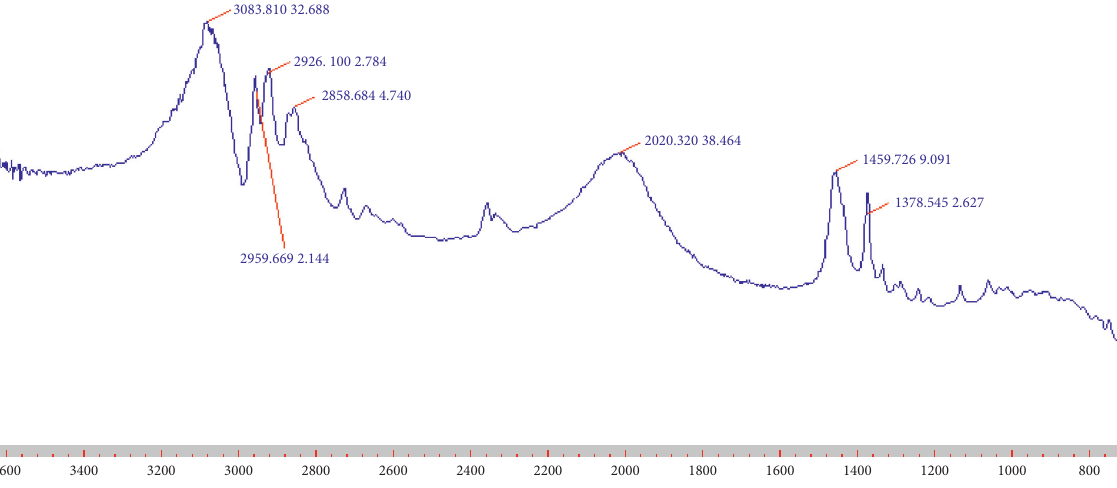
Figure 6: IR spectrum of hexane oxide products formed in the liquid phase from the radiolysis of hexane and air in the nano-Al at room temperature ( d � 20 nm, m � 0.2g nano-Al 2 O 3 +5ml solution, T � 24 ° C, P � 0, 36